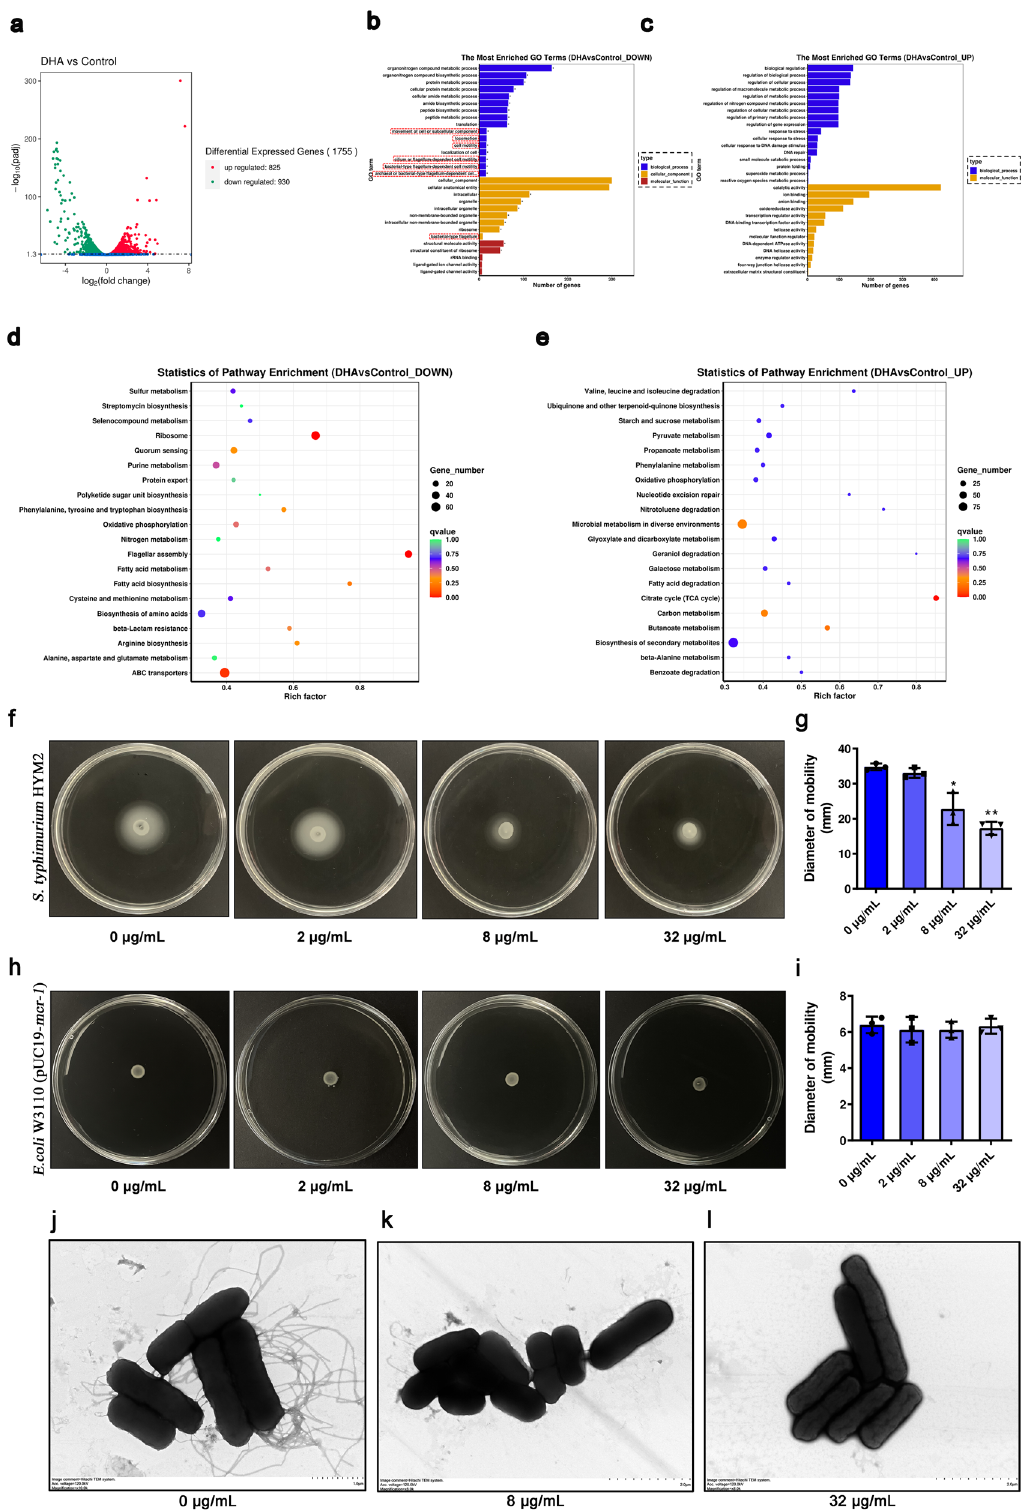
Fig. 7 DHA reduces the virulence of bacteria by hindering the fl agellar assembly and energy metabolism. a The differentially expressed genes of E. coli W3110 (pUC19- mcr-1 ) treated with DHA or control. b , c The most enriched GO terms associated with biological process, cellular component and molecular function, and the downregulated genes were mainly focused on the motility of bacteria (outlined in red). d – i The downregulated genes ( d ) and up- regulated genes ( e ) with DHA treatment compared with the control are shown. The motility of S. typhimurium HYM2 ( f , g ) and E. coli W3110 (pUC19- mcr-1 ) ( h , i ) on agar plates was photographed and the mobility diameter was measured ( n = 3). j – l The fl agellar morphology of S. typhimurium HYM2 treated with DHA at concentrations of 0 µ g/mL (j), 8 µ g/mL ( k ) and 32 µ g/mL ( l ) was observed by TEM (Hitachi TEM system, Acc.voltage = 120.0 kV, bar = 1 μ m ( j ), 2 μ m ( k , l )) ( n = 3). * P < 0.05. ** P < 0.01.